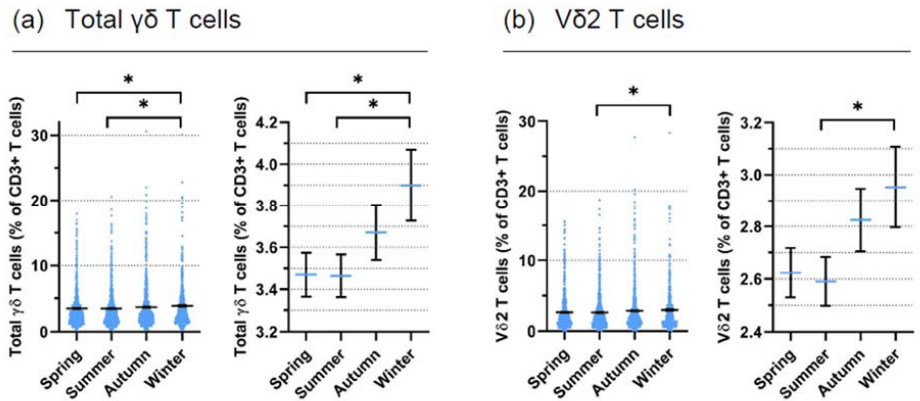
Figure 1. Seasonal variation of γδ T cells in random blood donors over ten years . A total of 2625 blood samples from random healthy adult blood donors collected from 2011 to 2020 were analyzed for the proportion of total γδ T cells ( a ) and V δ 2 T cells ( b ) among CD3 + T cells. In the left panels, all individual data points are displayed, while in the right panels, mean values ± SEM are shown. For statistical analysis, a linear regression was performed. The dependent variable was total γδ T cells (R 2 = 0.003) in ( a ) and V δ 2 T cells (R 2 = 0.002) in ( b ). For statistical comparison, the reference season was Winter, * p < 0.05.